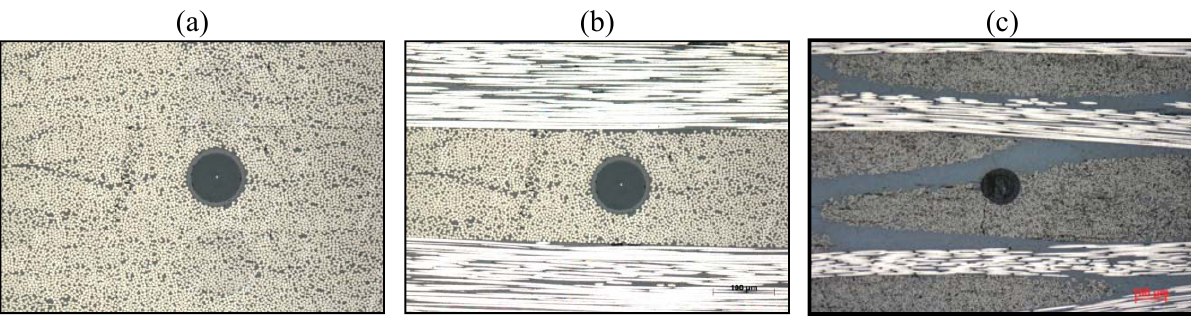
Figure 1. FBG embedded (a) in a unidirectional laminate, (b) in a cross-ply